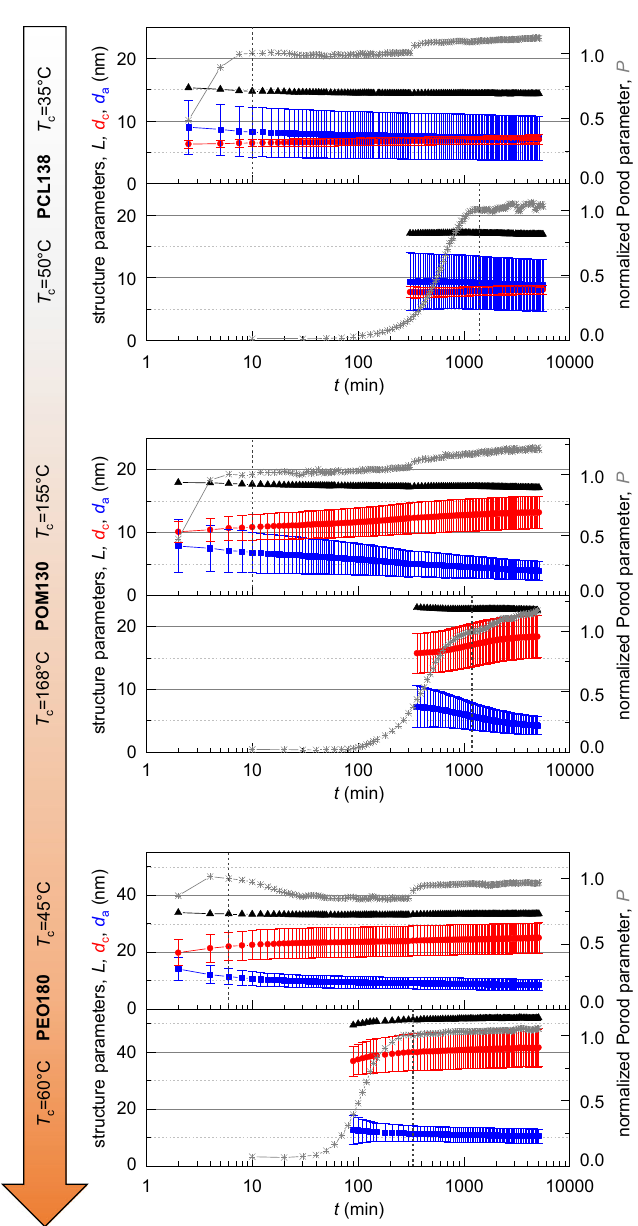
Fig. 3 Structural parameters as obtained by SAXS during isothermal crystallization from the melt as a function of the crystallization time. For each sample system the isothermal crystallization was performed for a high (~20 K) and a low (~5 K) supercooling Δ T . The arrow represents the expected in fl uence of the ICD according to Fig. 2. RHS y -axis: time-dependent Porod parameter P (grey) normalized to 1 at the end of the primary crystallization process (dotted line). LHS y -axis: time-dependent long period L (black), amorphous thickness d a (blue), and crystalline thickness d c (red). σ c/a are shown as “ error bars". For PEO the scale of the left y -axis is increased roughly by factor 2. Source data are provided as a Source Data fi